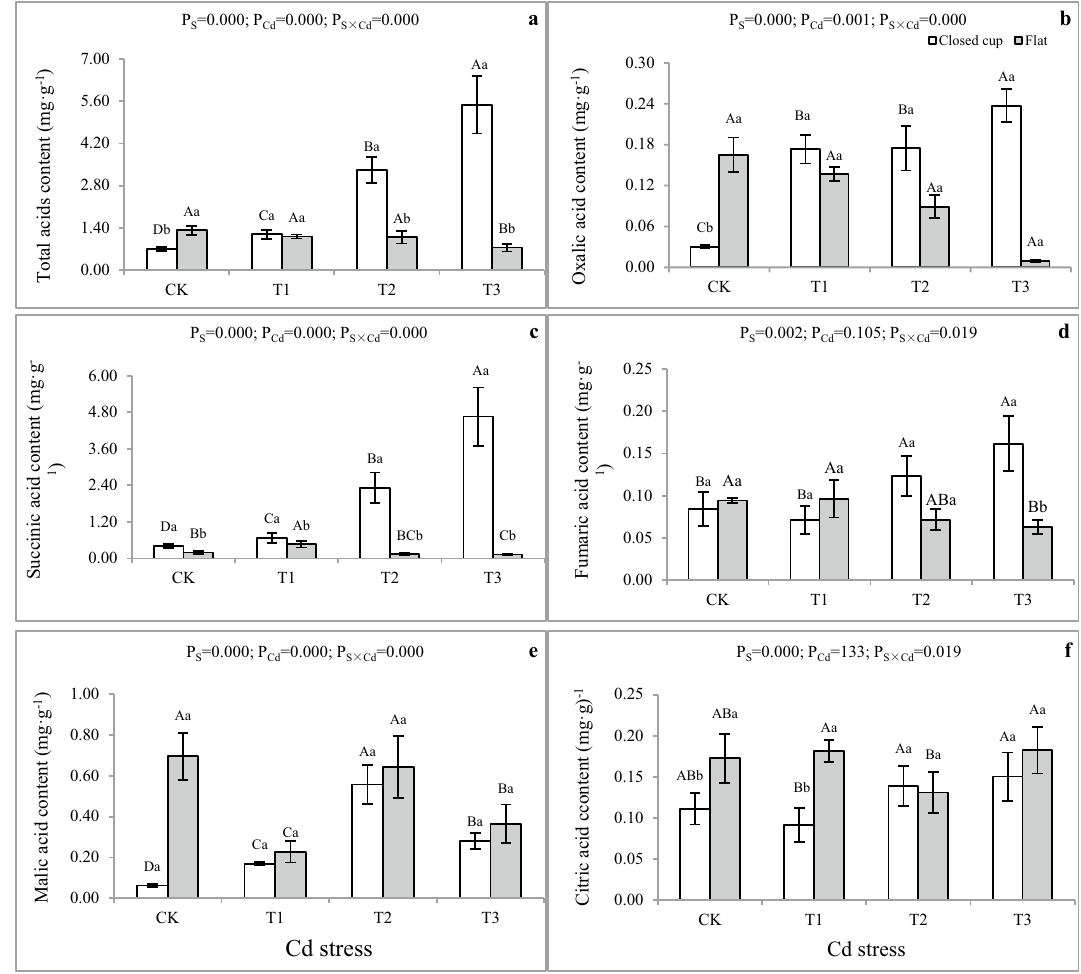
Figure 4. Effect of Cd stress on the amount of LOWOAs in fruiting bodies of A. bisporus . ( a ) Total organic acid content. ( b ) Oxalic acid content. ( c ) Succinic acid content. ( d ) Fumaric acid content. ( e ) Malic acid content. ( f ) Citric acid content. Different capital letters indicate significant differences among Cd stresses under the same sampling stage determined by LSD’s test with p < 0.05; different lower letters indicate significant differences within the sampling stage under the same Cd stress concentration determined by LSD’s test with p < 0.05. P S : effect of sampling time; P Cd : effect of Cd concentration; P S×Cd : Interaction between sampling time and Cd concentration. Error bar: